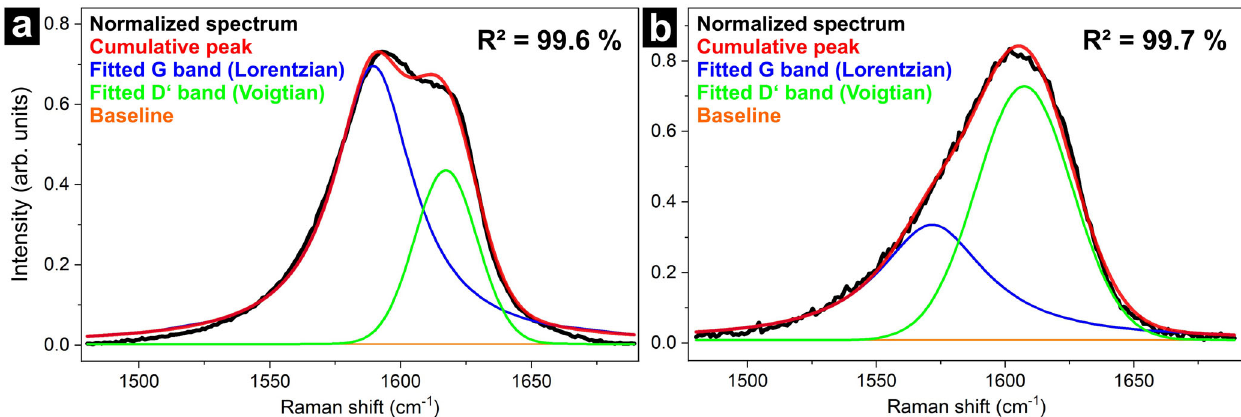
Fig. 2 Two-peak fi t of the (G + D ’ )-Raman band. Exemplary two-peak fi ts of the (G + D ’ )-band in the Raman spectrum of a CNTs and b COs. A Lorentzian peak shape is used to fi t the G-band, and a Voigtian peak pro fi le is used to fi t the D ’